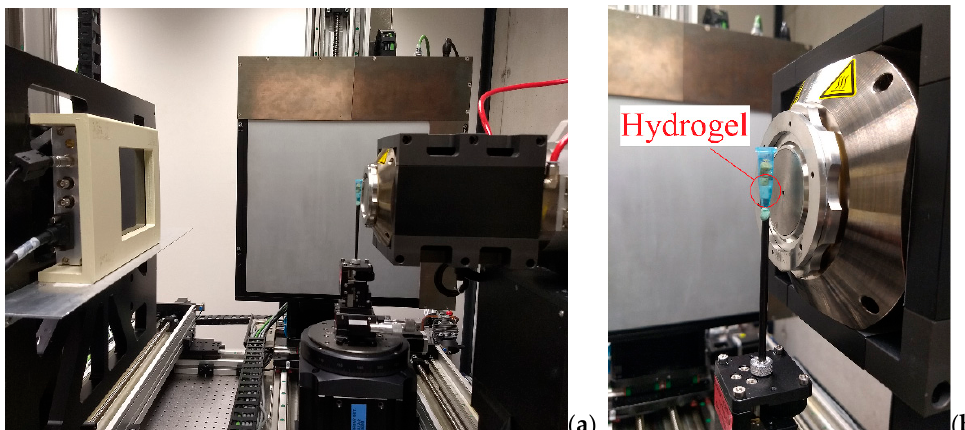
Figure 2. Positioning of the hydrogel for the tomography. ( a ) Overview of TORATOM and ( b ) positioning of the